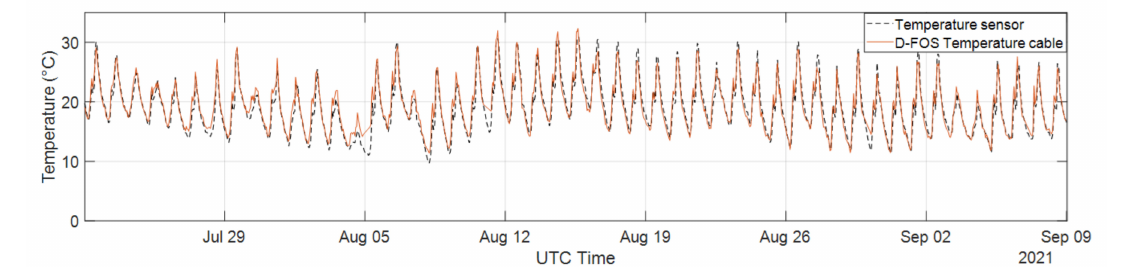
Figure 11. Comparison between temperature profiles at a known position: the black dashed line refers to the temperature sensor totally covered by the polyurethane adhesive whereas the orange one is the trend determined by the D-FOS temperature cable.